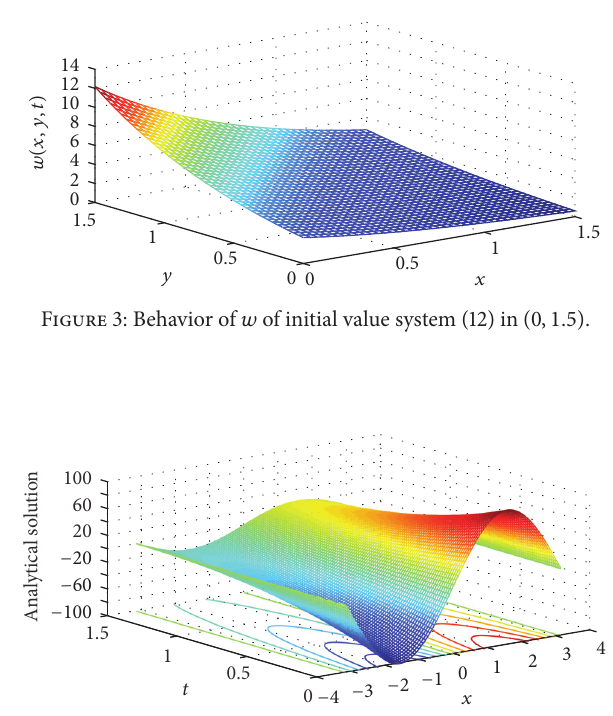
Figure 4: The behavior of 𝑢 and V of initial value system of coupled viscous Burgers’ equation (16) in (−𝜋,𝜋) at different time